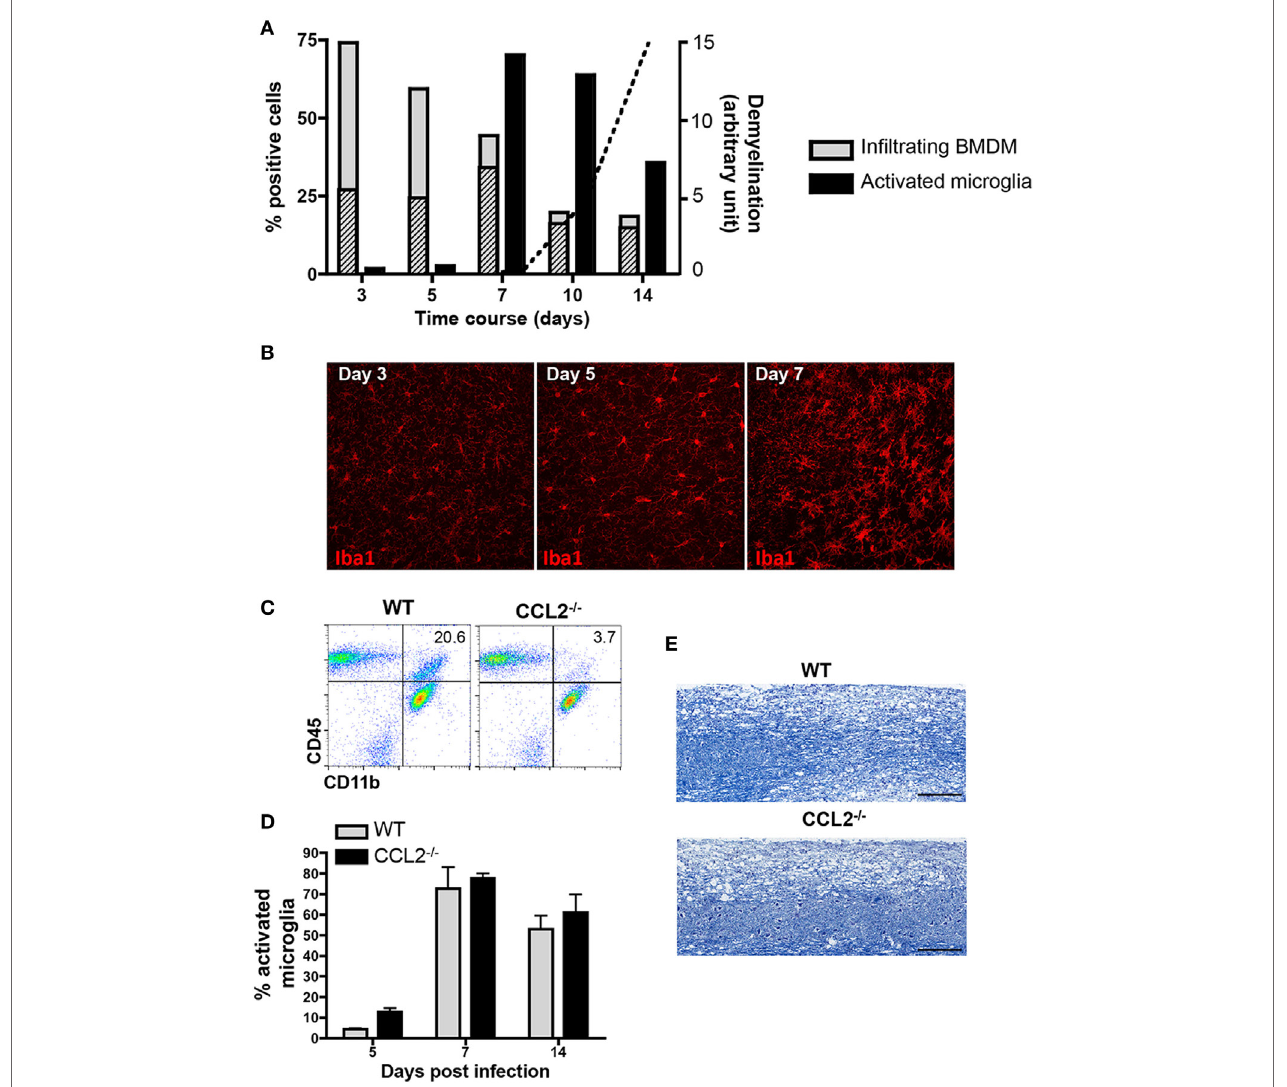
FigUre 1 | Demyelination correlates with microglia activation and is not affected in absence of bone marrow-derived macrophage (BMDM) central nervous system (CNS) infiltration. (a) Brains dissected from JHMV-infected wild-type (WT) mice were analyzed by flow cytometry for infiltrating CD11b + F4/80 + BMDM and activated CD45 low CD11b + microglia defined by their major histocompatibility complex (MHC) Class II + phenotype between days 3 and 14 p.i. Gray bars depict the percentage of total CD11b + F4/80 + BMDM within infiltrating CD45 hi leukocytes, with striped bars representing the MHC Class II expressing BMDM fraction. Black bars represent the proportion of Class II + cells within the microglia population. Data are from three-pooled mice per time point and representative of at least three experiments. The superimposed dotted line shows the relative kinetics and extent of demyelination in arbitrary units. (B) Microglia morphological changes at days 3, 5, and 7 p.i. were visualized by confocal microscopy of brain sections stained with anti-Iba1 monoclonal antibody (mAb). 40 × magnification. Pictures are representative of four separate animals. (c) Brains of WT and CCL2 − / − infected mice at day 14 p.i. were analyzed for CD45 and CD11b expressing myeloid cells. Representative flow cytometry plots show a reduction of CD11b + cells within the infiltrating CD45 hi population in the absence of CCL2. Numbers represent the percentage of CD11b + cells within CD45 hi infiltrates. (D) Brains of infected WT and CCL2 − / − mice between days 5 and 14 p.i. were analyzed by flow cytometry for activated MHC Class II + microglia Bar graphs depict the percentage of class II + cells within CD45 low CD11b + cells. Data represent the mean ± SEM of three experiments with n = 3-pooled mice per group per experiment. (e) Demyelinating lesions within spinal cords of WT and CCL2 − / − mice at day 21 p.i. were visualized by Luxol Fast Blue